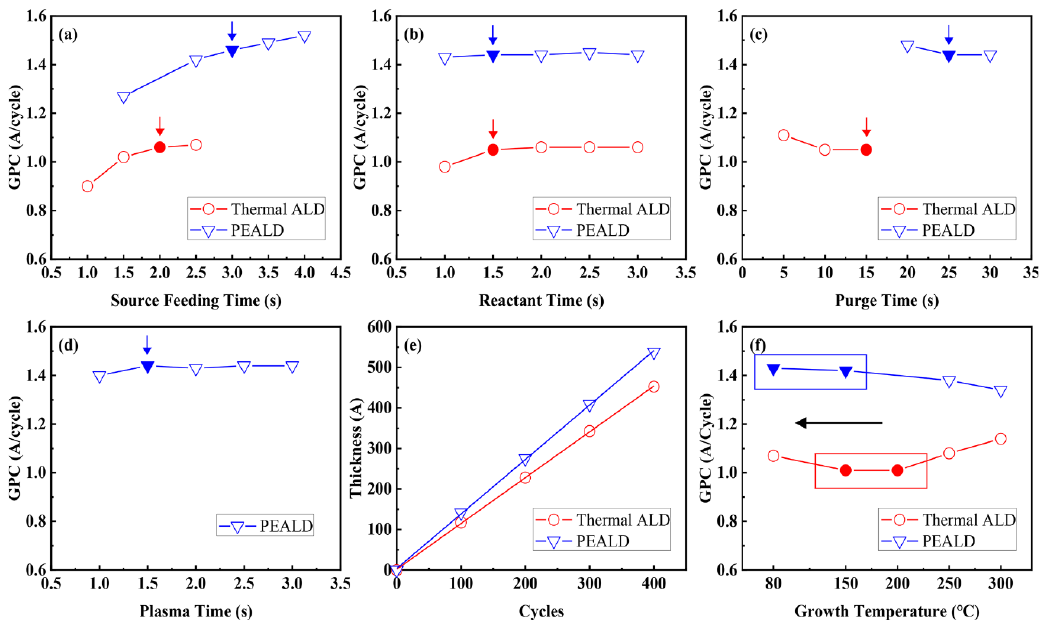
Figure 1. ( a – d ) GPC values of HfO 2 deposited at 80 °C by thermal ALD and PEALD as functions